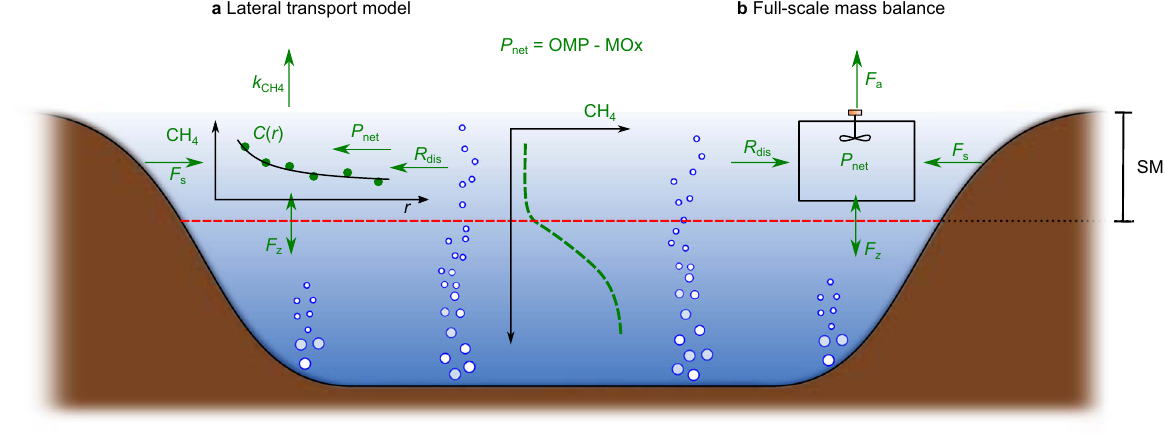
Fig. 1 | Conceptual schematic of the CH 4 budget components in the surface mixed layer (SML) and methodological approaches. CH 4 mass balance compo- nents: diffusive CH 4 emissions to the atmosphere ( F a ), vertical transport ( F z ), bubble dissolution ( R dis ), littoral sediment fl ux ( F s ). The net CH 4 production rate ( P net )intheSMLisestimatedusinga1-Dlateraltransportmodelanda0-Dfull-scale mass balance in a and b , respectively. P net is the balance between oxic CH 4